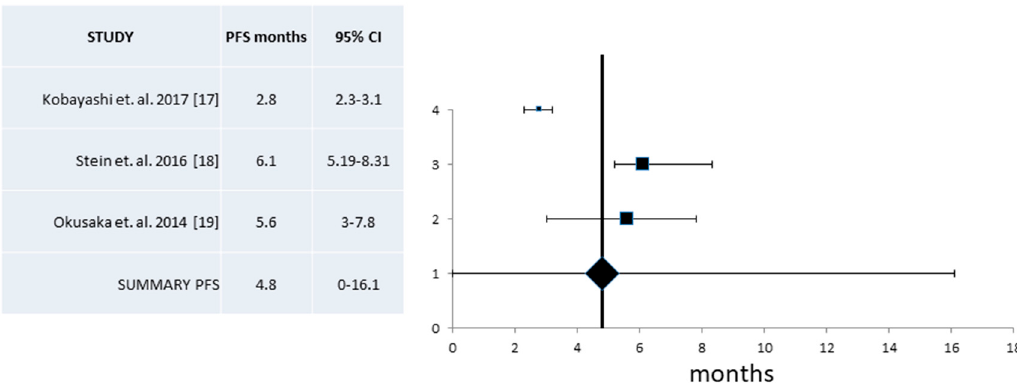
Figure 8. Pooled analysis of Progression-Free Survival (PFS) and 95% Confidence Intervals (CI) from phase II trials. Three trials with a total of 91 patients that provided information for the PFS were included in this analysis and revealed an overall PFS of 4.8 months (95% CI 0–16.1 months).